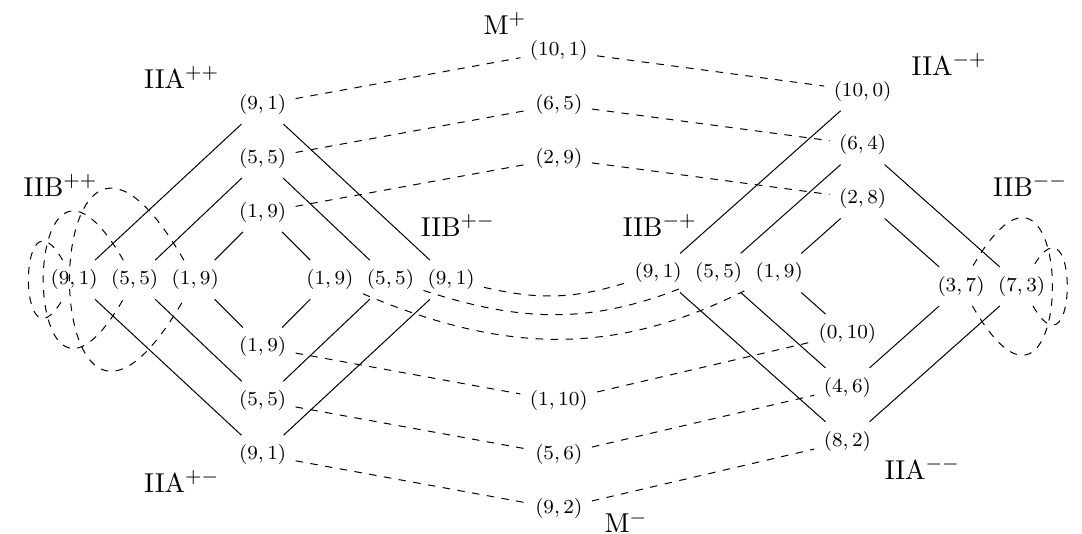
Figure 4 . T-dualities (solid lines) and S-dualities (dashed lines) relating type II strings theories and M-theory, keeping track of spacetime signature. See (cid:12)gure 3 for labels distinguishing timelike and spacelike T- and